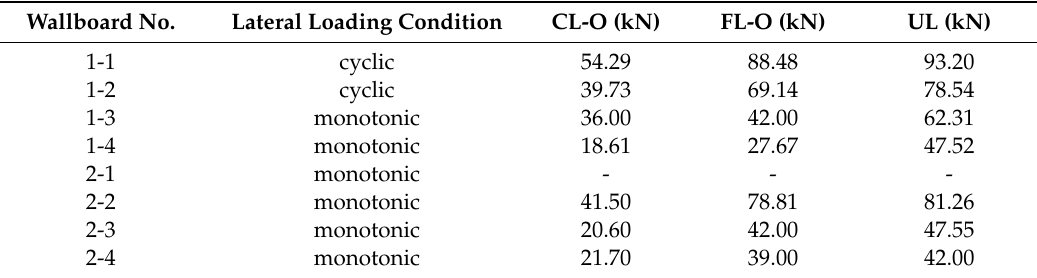
Table 3. The experimental records of the HMES wallboards. Wallboard No.